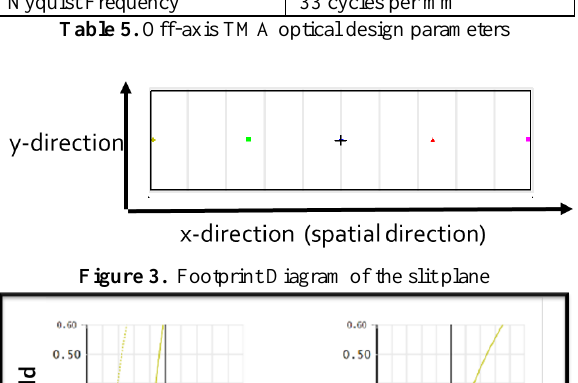
Figure 2. TMA telescope design layout of the HSI Optimization process started with the standard aspheric surface.